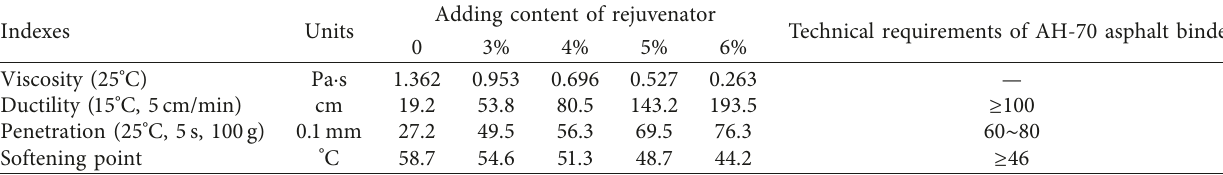
Table 4: Performance properties of regenerated RAP binder.